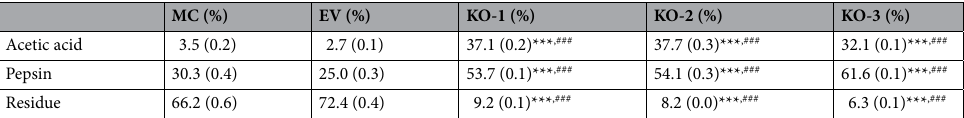
Table 8. Solubility of collagen from MC, EV and KO clones. The numbers represent percentage of total collagen sequentially extracted with 0.5 M acetic acid and pepsin, and final residues. Values represent mean ± S.D. (n = 3) of triplicate analysis of collagen from MC, EC, and KO clones. Statistical differences were determined by Kruskal–Wallis one-way analysis of variance and means comparison with the controls by Dunnett’s method. MC MC3T3-E1, EV empty vector, KO knock-out. *** p < 0.001 between MC and KO; ### p < 0.001 between EV and KO,